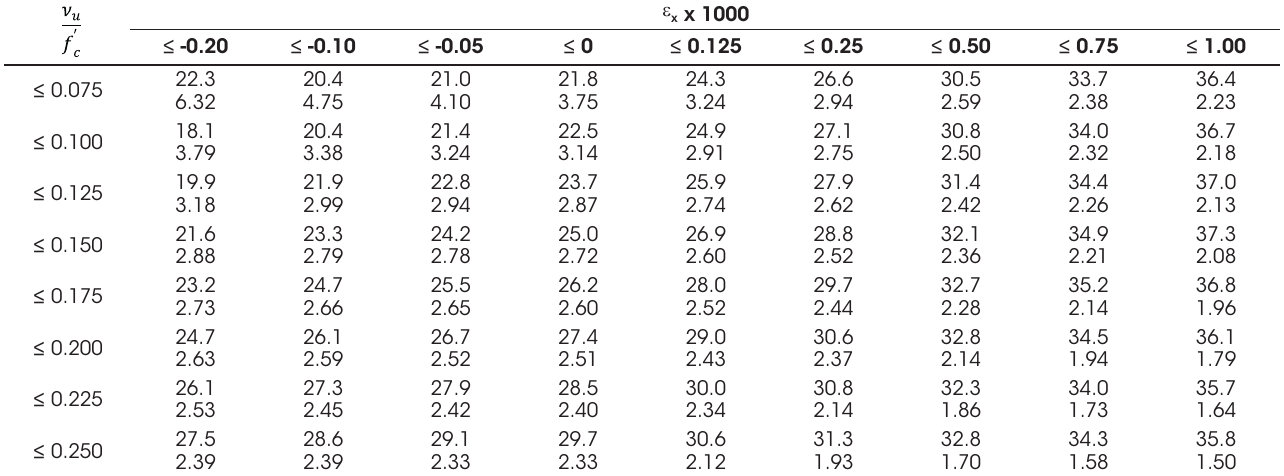
Values of θ and b given by